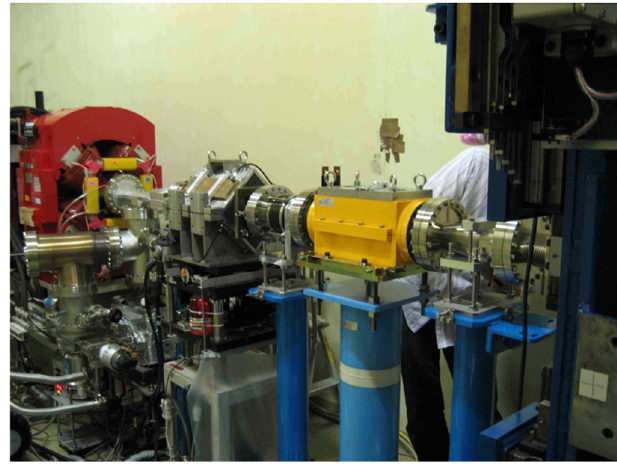
FIG. 16. (Color) Photograph of the PSM (yellow) installed in the PF